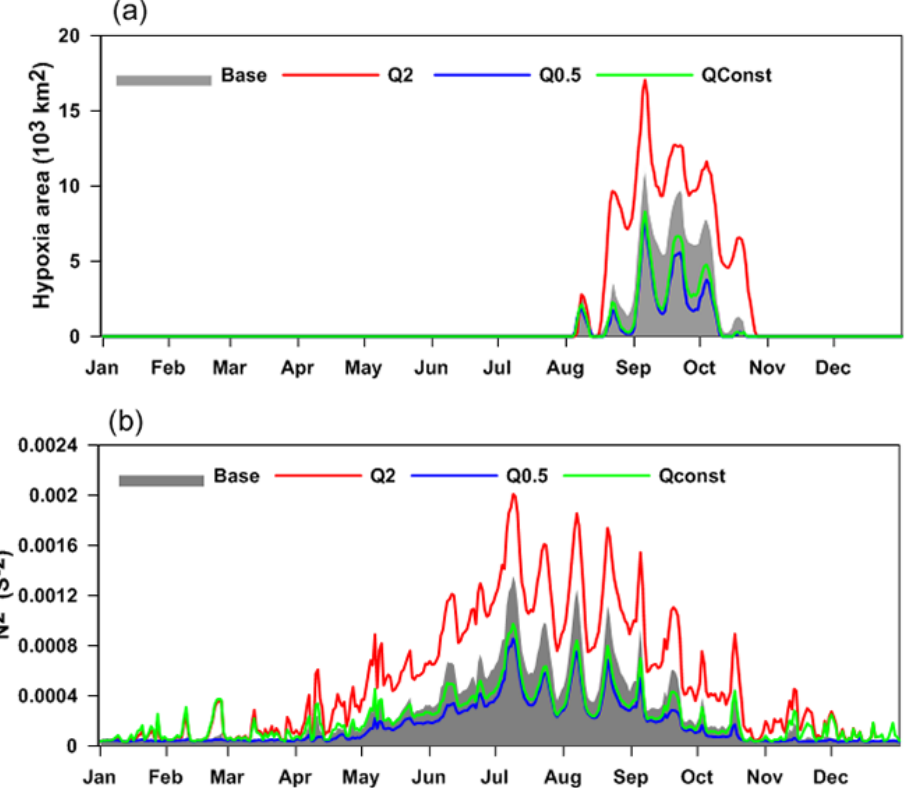
Figure 8. (a) and (b) are the hypoxic area (DO<2mgL − 1 ) and N 2 in the river discharge experiment, respectively. The gray shaded part represents the base run and the red, blue, and green curves represent Q 2 , Q 0 . 5 , and Q const , respectively.